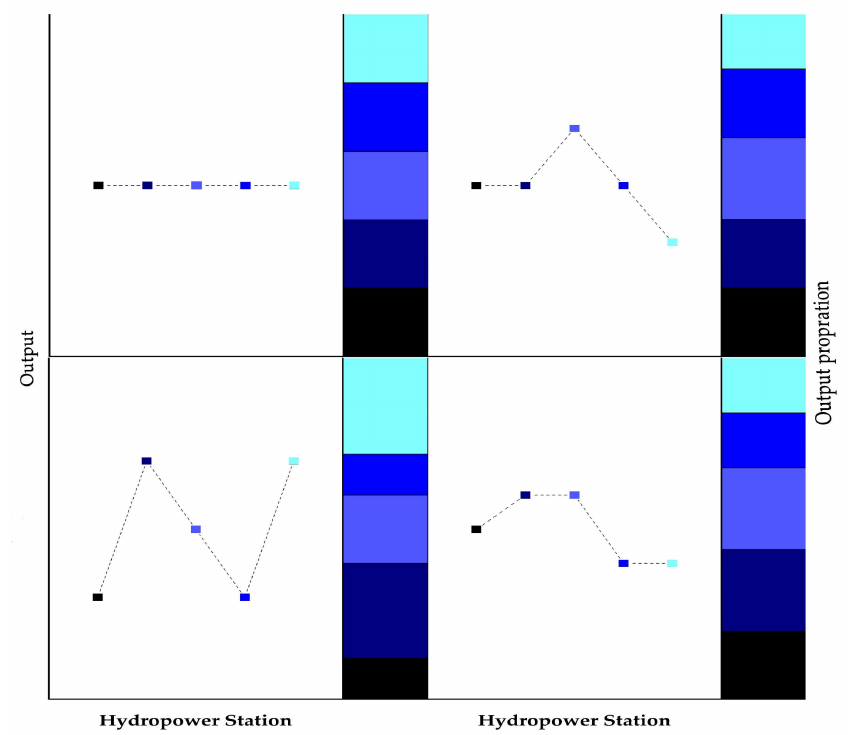
Figure 5. The schematic diagram of “series